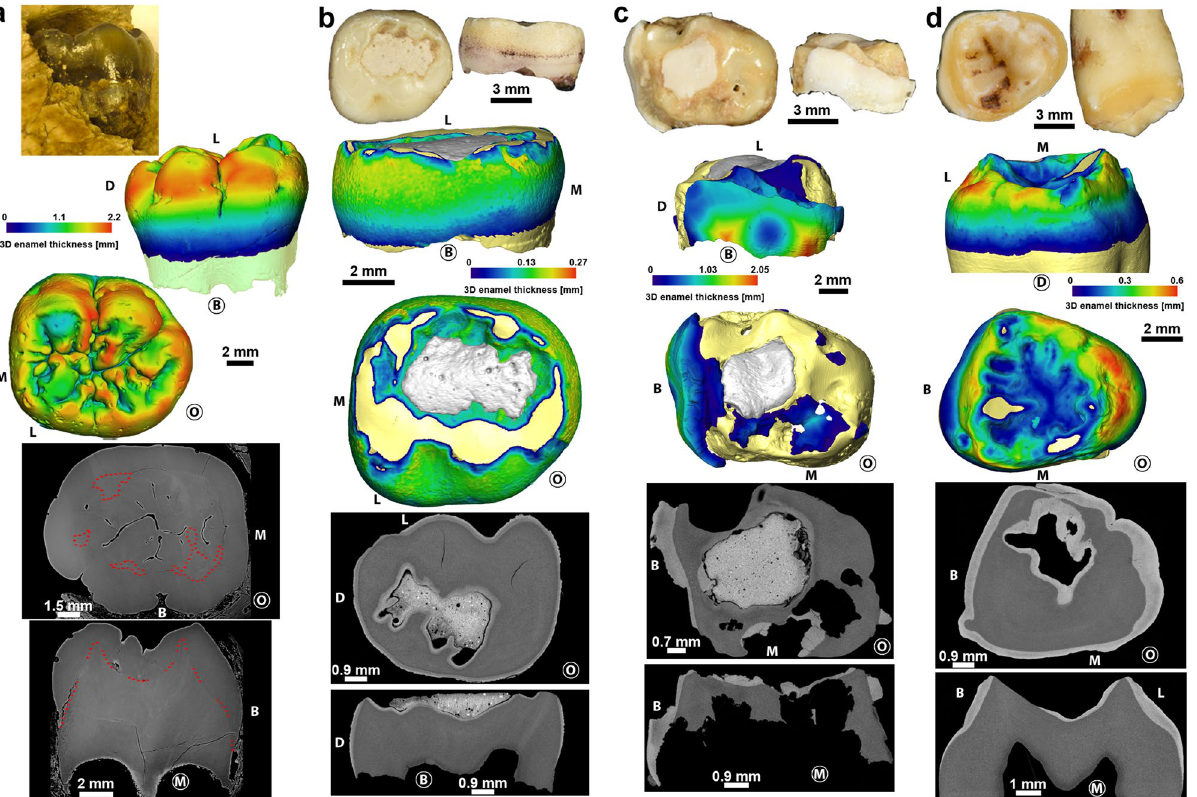
Figure 5. Comparison of the GAR IVE LRM1 ( a ) with three modern human teeth affected by different forms of amelogenesis imperfecta ( b – d ; see Supplementary Text S4for details). Photographs (top), 3D enamel thickness maps (middle) and 2D virtual sections (bottom) show that despite the loss of contrast, GAR IVE has a normal enamel thickness and morphology. Anatomical orientation is shows using ‘M’ for mesial, ‘D’ for distal, ‘B’ for buccal, ‘L’ for lingual and ‘O’ for occlusal. The side of the tooth in front view is